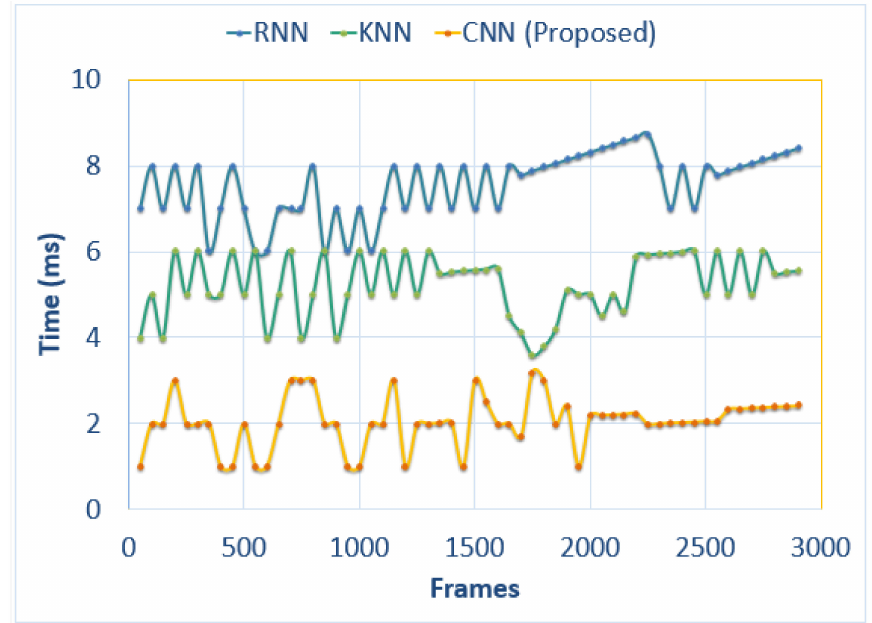
Figure 17. Comparison of the computational efficiency of our proposed model with other state of the art models over the MICC